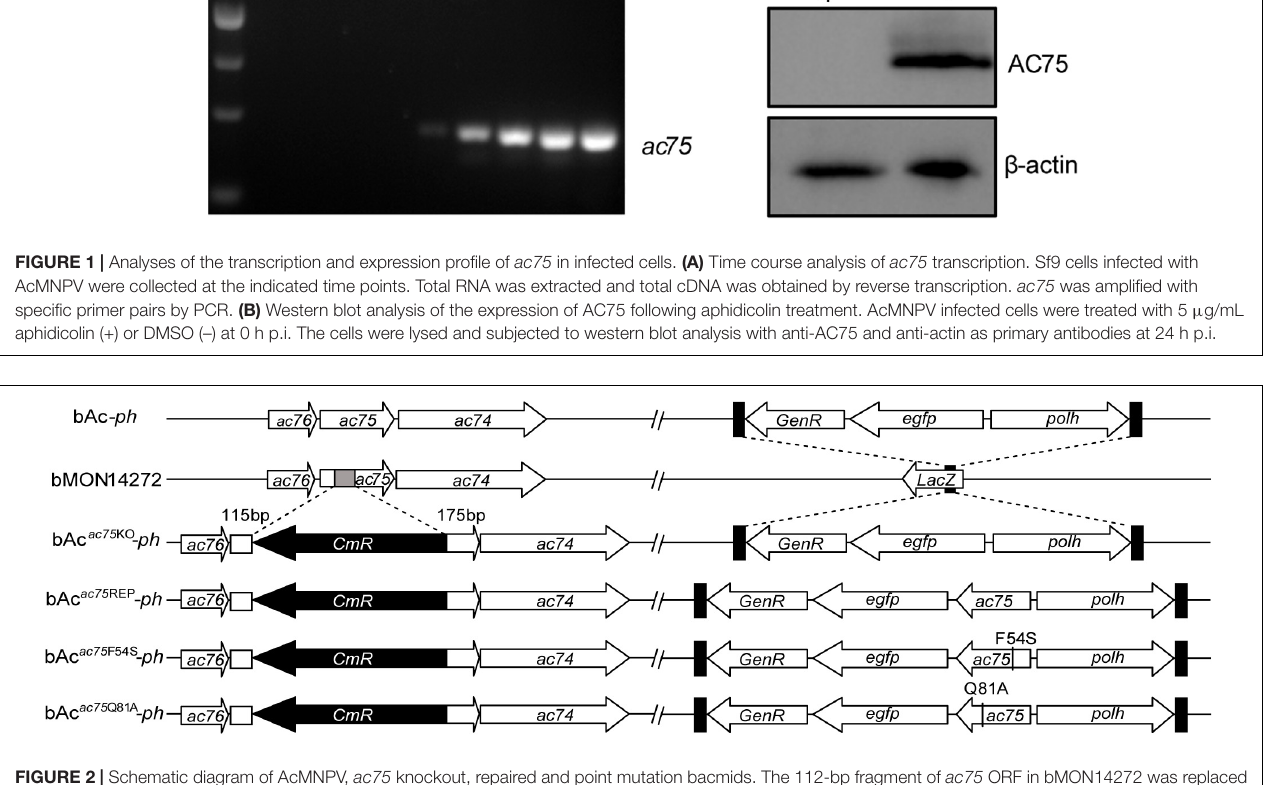
FIGURE 2 | Schematic diagram of AcMNPV, ac75 knockout, repaired and point mutation bacmids. The 112-bp fragment of ac75 ORF in bMON14272 was replaced with a CmR cassette via homologous recombination to generate bAc ac 75KO . bAc- ph and bAc ac 75KO - ph were generated by inserting the polh and egfp genes into the polh locus of bMON14272 and bAc ac 75KO , respectively. The ac75 , ac75 F54S or ac75 Q81A controlled by the ac75 native promoter with the polh and egfp genes were inserted into the polh locus of bAc ac 75KO to generate bAc ac 75REP - ph , bAc ac 75 F 54 S - ph and bAc ac 75 Q 81 A - ph ,